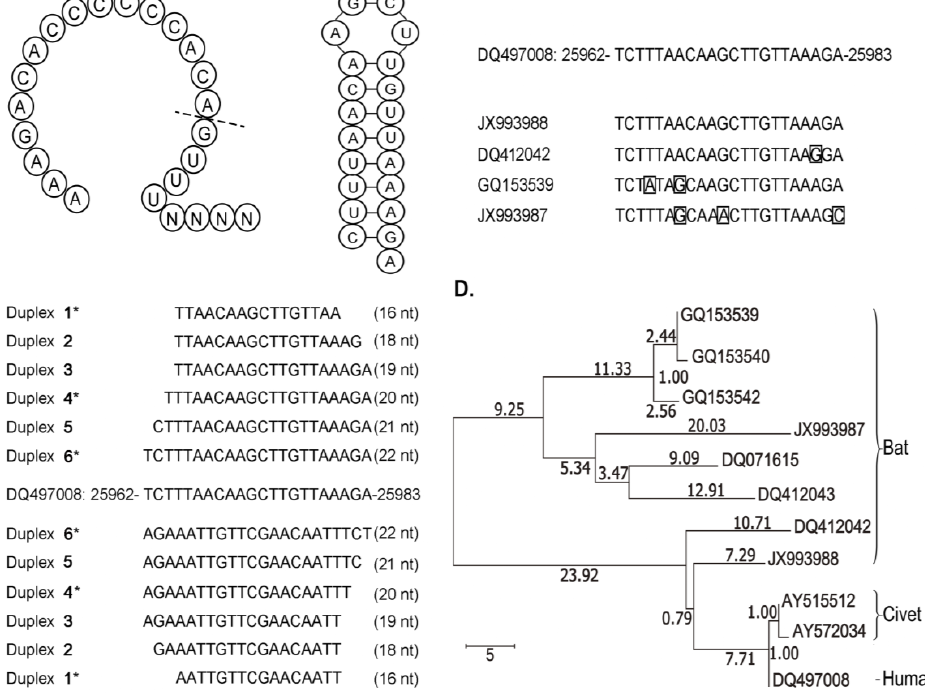
Figure 2. Clues to the origins of SARS-CoV-cpsR-19. All of the genome sequences are represented by their GenBank accession numbers (e.g., DQ497008). ( A ). hsa-tiR-MDL1-16 is derived by cleavage after it starts transcription of the long H-strand primary transcript at the position 561 of human mitochondrial genome (Left). SARS-CoV-cpsR-21 can form a hairpin (Right). ( B ). 16-nt, 18-nt, 19-nt, 20-nt, and 22-nt siRNA duplexes were used for RNA interference (RNAi) experiments. *16-nt, 20-nt, and 22-nt palindromic small RNAs (cpsRNAs) were not detected in this study. ( C ). SARS-CoV-cpsR-19 was detected from a complemented palindromic motif TCTTTAACAAGCTTGTTAAAGA in the SARS-CoV genome. All of the 22-nt homologous sequences in the civet betacoronavirus genomes were identical to the complemented palindromic motif, whereas four genotypes of 22-nt homologous sequences were detected in the bat betacoronavirus genomes, however only one of them was identical to it. ( D ). The phylogenetic tree was built by the Neighbor Joining (NJ) method using the ORF3b gene from human betacoronavirus, eight homologous sequences from bat betacoronaviruses, and two homologous sequences from civet betacoronaviruses. The branch's length corresponds to an average number of nucleotide changes per 100 nucleotides.